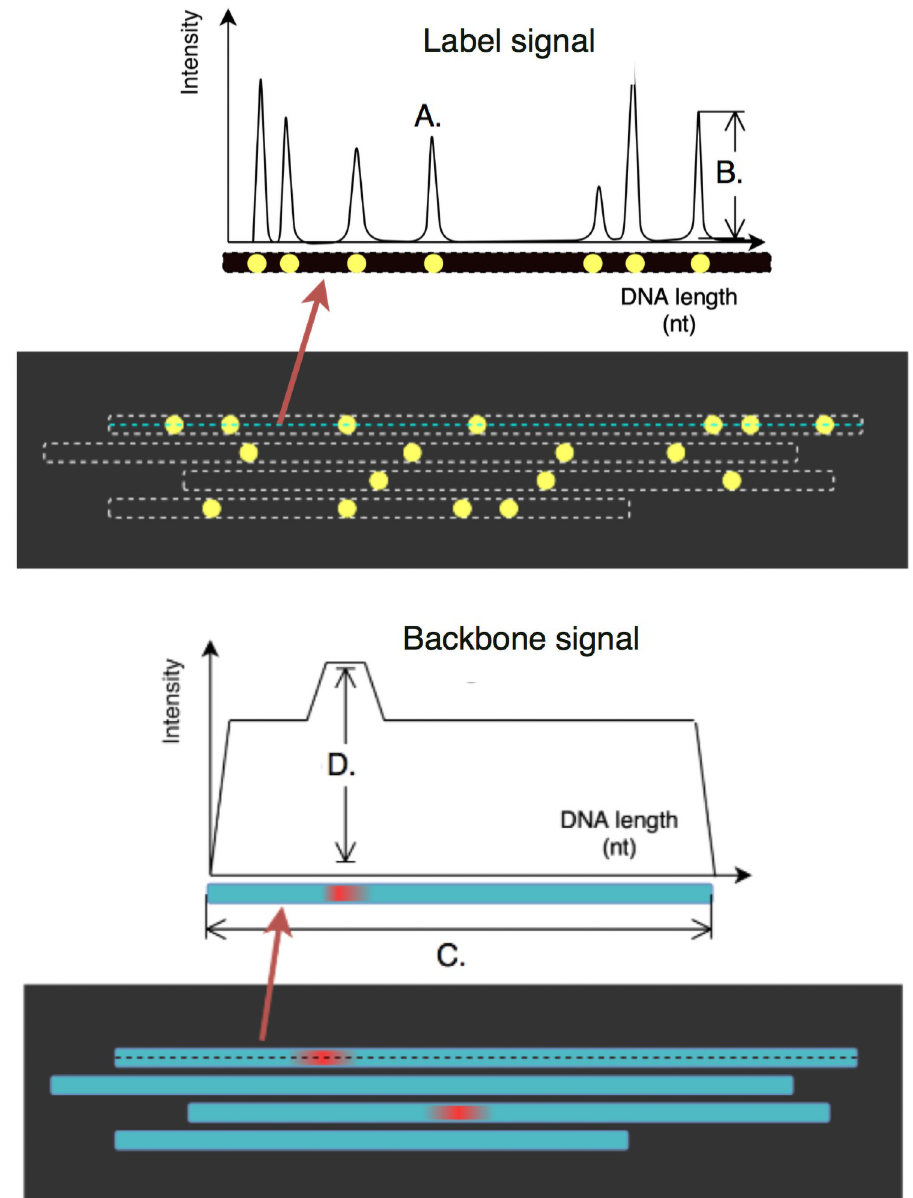
Fig 3. Frame pairs as produced by the BNG platform. Each scan produces two frames (images), with labels (top) and backbones (bottom). The top molecule’s label and backbone intensities are illustrated as 1D signals above the frames. In the label frames, peaks correspond to label centers (A), with peak heights indicating label intensity (B). In the backbone frames, stretches of equal intensity delineate the molecules (C) with occasional higher intensity stretches indicating possible DNA entanglement (D). Note that the frames shown here are in a horizontal orientation for illustration